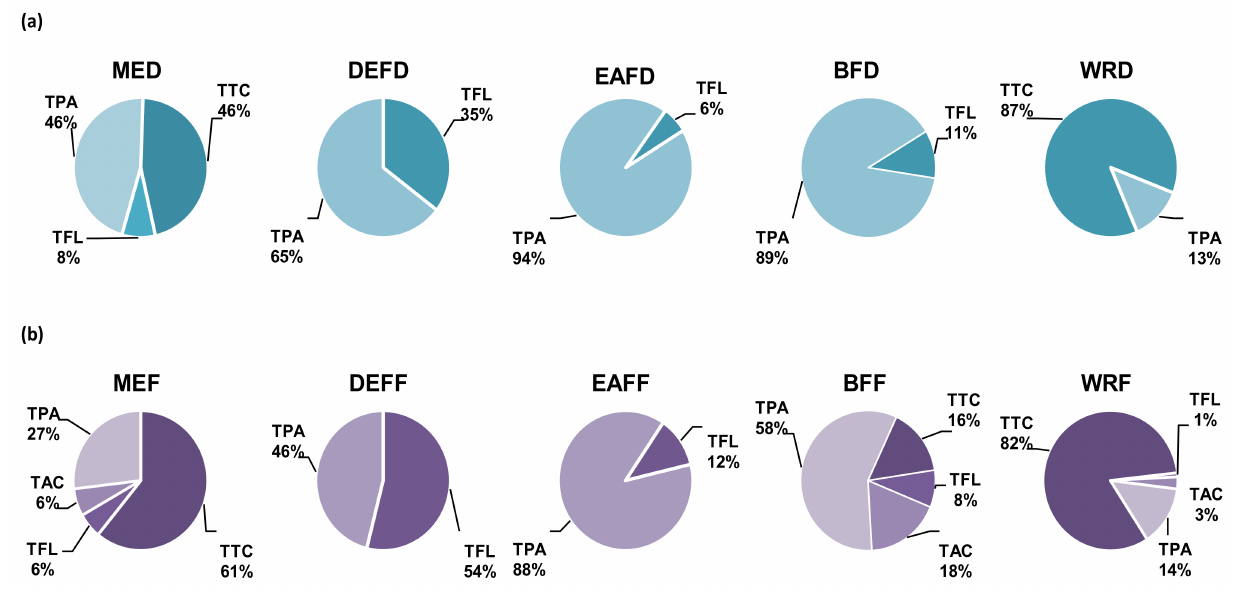
Figure 2. Contribution of individual groups of compounds to total phenolic contents (TPH+TTC) in Prunus spinosa fruit extracts: ( a ) dried fruits and ( b ) fresh fruits. TPA, TAC, and TFL: total contents of phenolic acids, anthocyanins, and flavonoids, respectively, determined by HPLC-PDA; TTC: total content of condensed tannins in procyanidin B2 (PB2) equivalents; TPH, sum of individual polyphenols by HPLC. For extract codes, see Table 1 and Section Abbreviations. The extracts/fractions from dried fruits were coded by the last letter “D”, while those from fresh fruits by “F”. For detailed experimental data on fresh fruits, see Magiera et al.